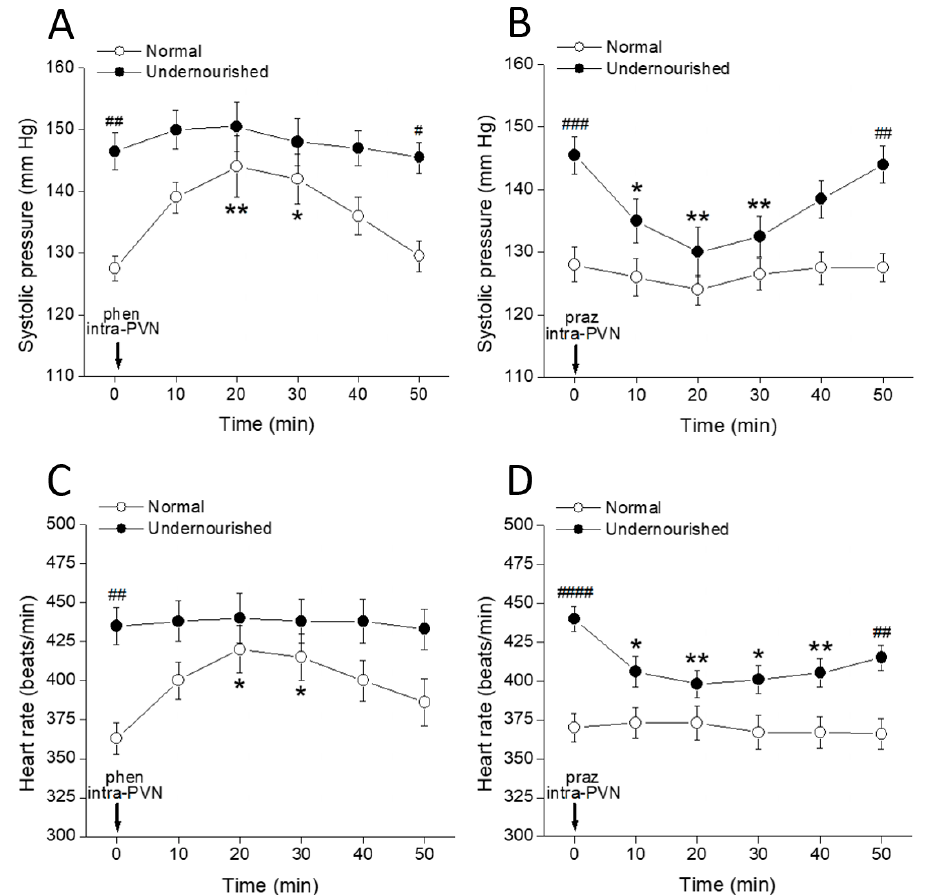
Figure 2. Time-course of changes in systolic pressure ( A , B ) and heart rate ( C , D ) of normal and prenatally undernourished rats after intra-PVN microinjection (arrow at time 0 min) of the α 1 -adrenoceptor agonist phenylephrine (phen, 6 nmol/side; ( A , C )) or the α 1 adrenoceptor antagonist prazosin (praz, 130 pmol/side; ( B , D )). Data are mean values ± SEM, n = six rats in each group. Two-way repeated measures ANOVA was used to identify the nutritional treatment and/or the time elapsed after drug microinjection as significant factors in the effect examined (( A ): for the effect of phenylephrine on systolic pressure, F nutrition(1, 10) = 53.40 and F time(5, 50) = 3.066; ( B ): for the effect of prazosin on systolic pressure, F nutrition(1, 10) = 25.43 and F time(5, 50) = 3.595; ( C ): for the effect of phenylephrine on heart rate, F nutrition(1, 10) = 21.69 and F time(5, 50) = 1.457; ( D ): for the effect of prazosin on heart rate, F nutrition(1, 10) = 30.13 and F time(5, 50) = 1.879). Significance symbols arising from the post hoc tests indicate either intragroup differences after phenylephrine or prazosin referred to the pre-drug control at time = 0 min (* p < 0.05, ** p < 0.01, Dunnett’s multiple comparisons test) or intergroup differences between normal and undernourished subjects ( # p < 0.05, ## p < 0.01, ### p < 0.001, #### p < 0.0001, Bonferroni’s multiple comparisons test).